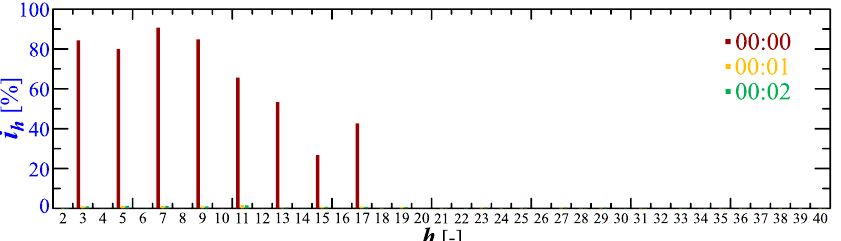
Figure 12. The amplitude spectrum of the current i h = f ( h ) recorded at 00:00, 00:01, and 00:02 for Case